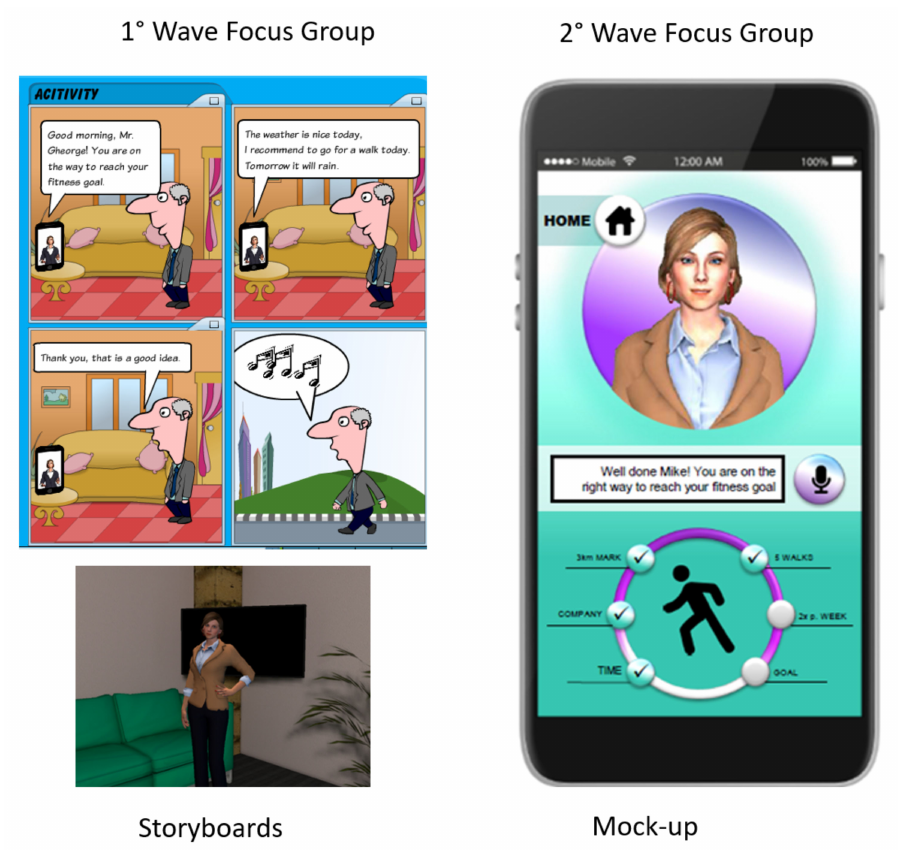
Figure 2. Examples of scenarios, storyboards and mock-ups used during the co-design (first and second focus-group